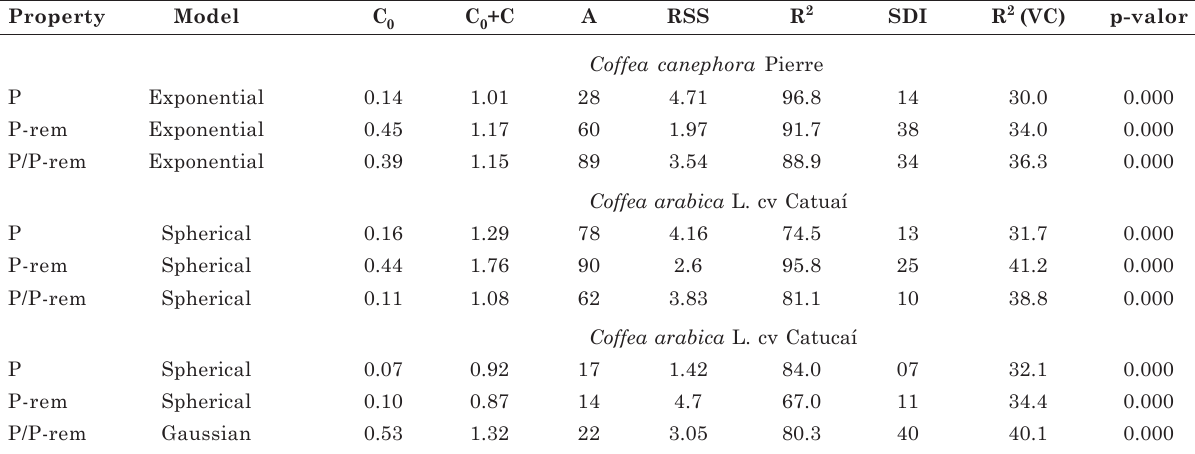
P: foliar phosphorus; P-rem: remaining phosphorus; P/P-rem: foliar phosphorus/remaining phosphorous.